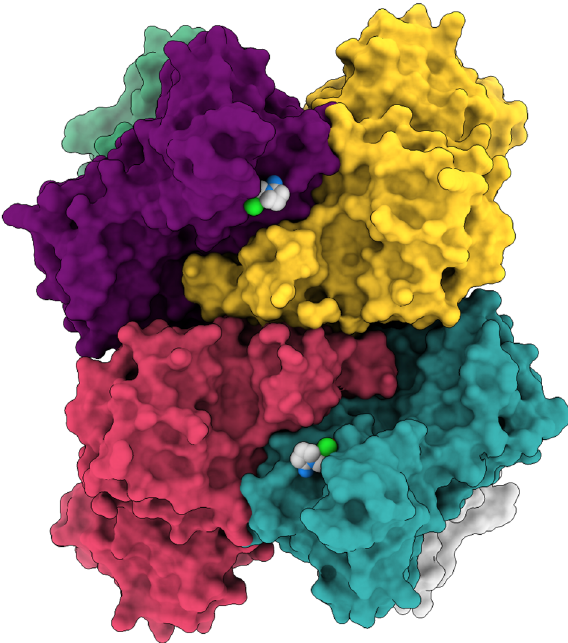
Fig. 5 Structure of SARS-CoV-2 hexamer with the bound Tipiracil in surface representation. Tipiracil bound to each subunit active site is shown with all atoms in color spheres (carbon, chlorine, nitrogen, oxygen in white, green, blue, and red,